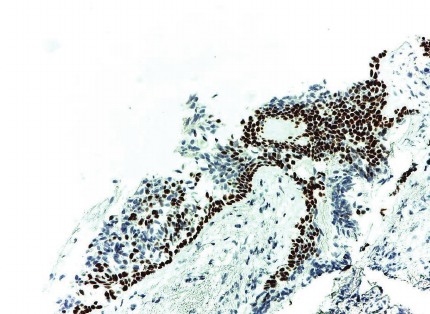
Figure 3: Immunocytochemical stain for p40 showing a well- defined layer of basal cells and basal cell hyperplasia consistent with